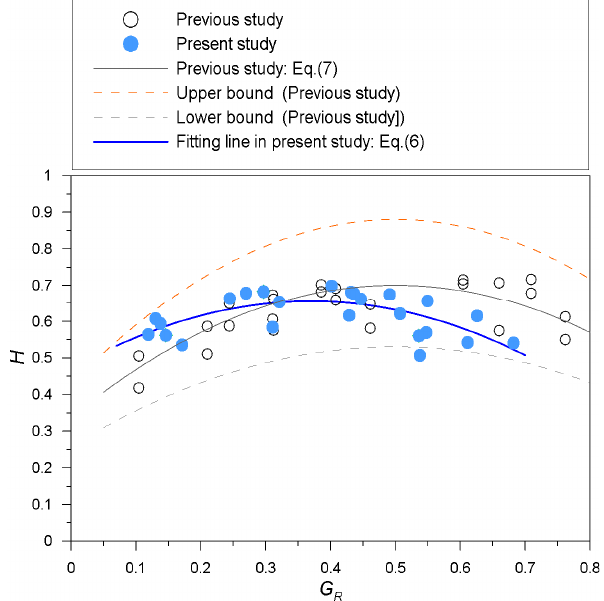
Figure 8. Empirical relationship between harmony ( H ) and the ratio of visible greenery ( G R ) and comparison with previous study [29]. Table 2. Comparison of mountain and urban streams.